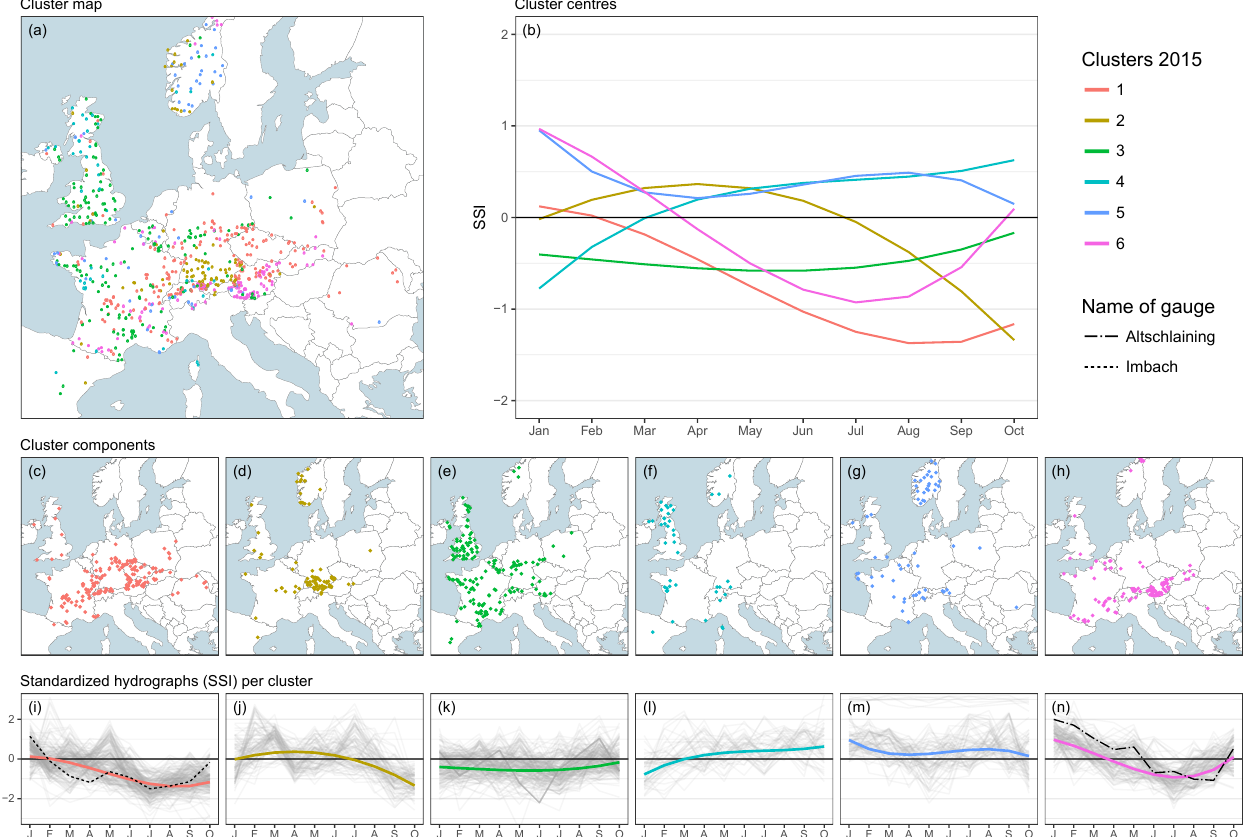
Figure 7. Clustering of the low flow event of 2015 based on monthly standardized streamflow index values SSI of the January–October period. (a) Combined cluster map showing allocation of catchments to the clusters, (b) combined map of functional models of each cluster, (c–h) cluster component maps, and (i–n) synoptic plots of standardized monthly hydrographs (indicated by thin grey lines) of Cluster 1–6 together with the functional model of each cluster center (bold colored line). Altschlaining is marked by a dotted and dashed black line, Imbach is marked by a dashed black line.